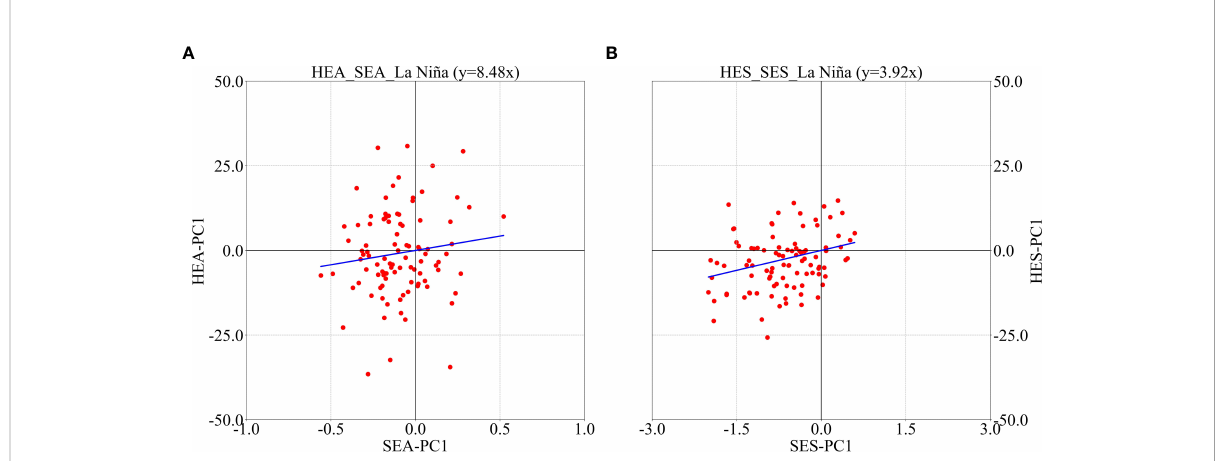
FIGURE 11 (A) Scatterplot of the SEA PC1 values against the HEA PC1 values for the La Niña decay events since 1979 (circle) and their linear fi tting line (blue) using NCEP Reanalysis 2 dataset. (B) as in (A) but for the SES PC1 values against the HES PC1 values.